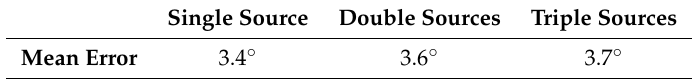
Table 3. Different frequencies acoustic sources broadcast by different